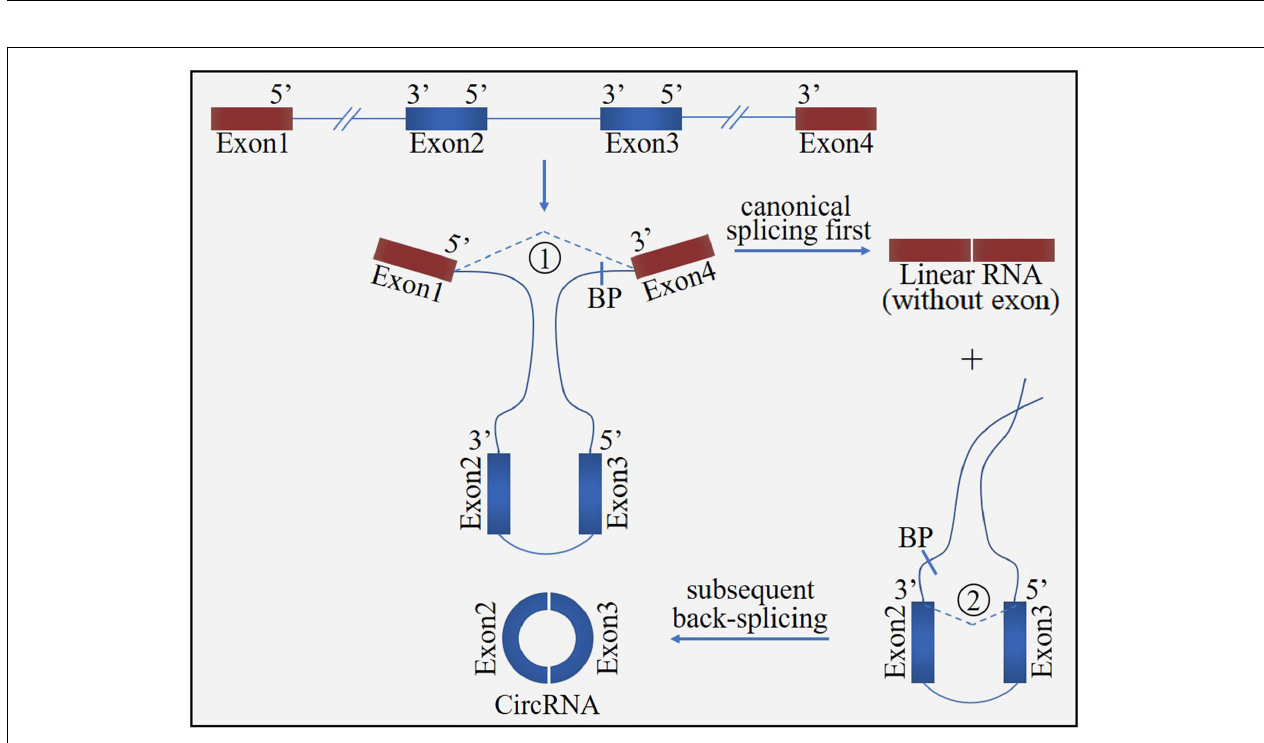
FIGURE 2 | The “exon skipping” or “lariat intermediate” model for circRNA formation. The process starts with canonical splicing for a linear RNA (exon1 and exon4) with skipped exons (exon2 and exon3) and a long intron lariat containing these skipped exons, which is then further back-spliced to form a circRNA. BP, branchpoint.